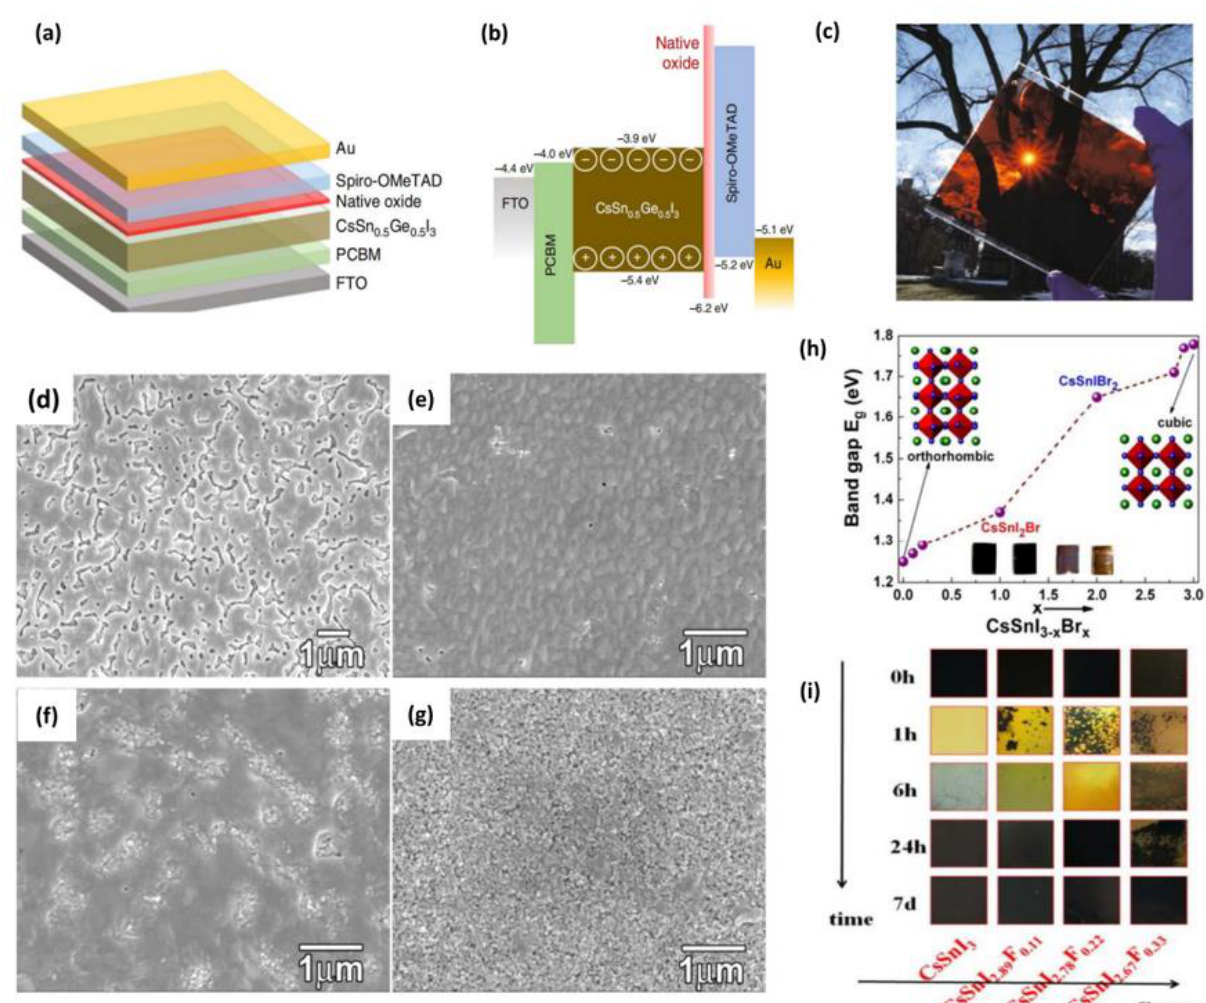
Figure 5. ( a ) Schematic illustration of the device structure of the CsSn 0.5 Ge 0.5 I 3 PVSC. ( b ) Correspond- ing device energy-level diagram. ( c ) Schematic illustration showing the deposition of ultrasmooth CsSn 0.5 Ge 0.5 I 3 perovskite film [77]. ( d – g ) Top−view SEM images of CsSnI 3 , CsSnI 2 Br, CsSnIBr 2 , and CsSnBr 3 displaying the morphological evolution. ( h ) The band gap variation with Br concentration [86]. ( i ) Macroscopic images of the color evolution in CsSnI 3-x F x films [87].